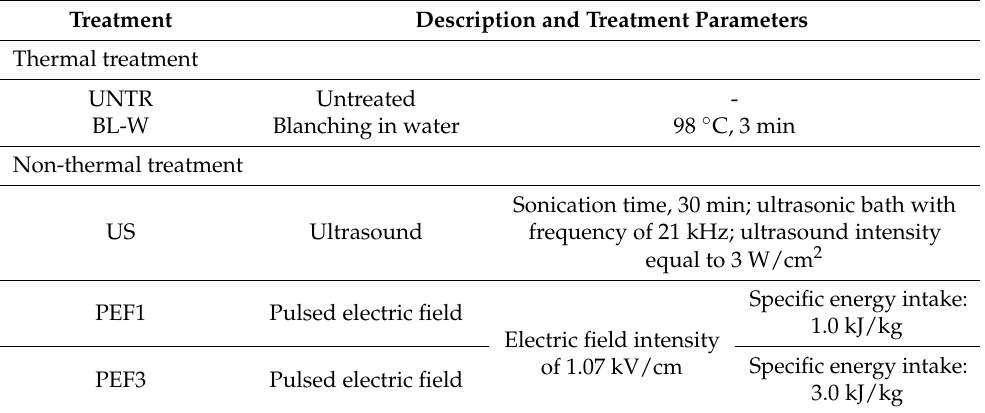
Table 3. Parameters of treatment of red bell pepper before subjecting to